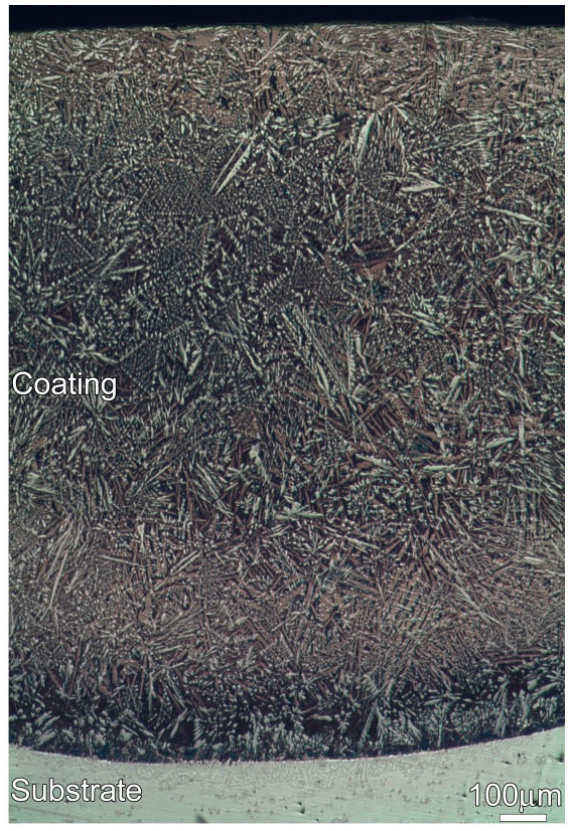
Figure 1. Optical metallograph of a cross-section of the coating. Materials 2019 , 12 , x FOR PEER REVIEW